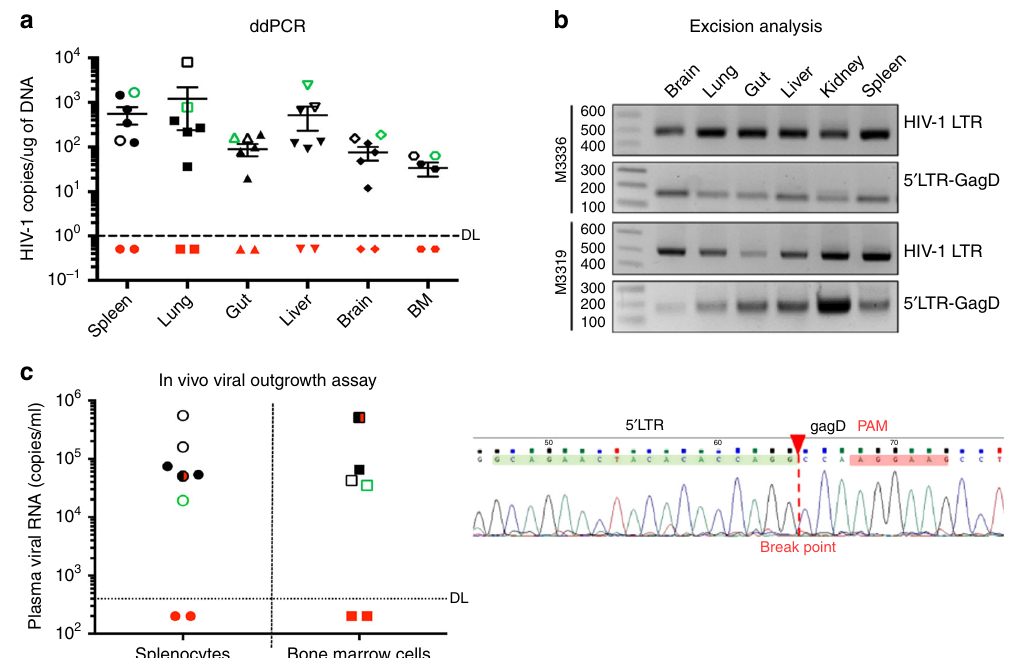
Fig. 8 Con fi rmation of viral elimination in HIV-1 infected and treated mice tissues. a Ultrasensitive ddPCR, with sensitivity of detecting 1 – 2 viral copies, was used in cross validation tests for viral DNA detection and performed in tissues of HIV-1 ADA -infected and infected/dual-treated animals. As a positive control, one animal each from the HIV-1 infected (open black structure) and HIV-1 and LASER ART (open green structure) groups are illustrated. These were placed together with the six infected animals from the dual treatment group illustrated as closed structures (either black or red). Dashed line represents the limit of detection. Results are shown as the mean ± SEM (BM: bone marrow). b Agarose gel analyses of the PCR assay of DNA from various tissues of two animals with no rebound shows the presence of segments of HIV-1 LTR DNA and detection of a 193 bp amplicon, indicative of excision of a DNA fragment between the LTR and the gag gene (top). The histogram illustrates representative results from sequencing of the 193 bp fragment highlighting the position of the 5 ’ LTR breakpoint, and Gag and PAM trinucleotide on the GagD RNA. c An in vivo viral outgrowth assay was performed by adoptive transfer of splenocytes and bone marrow cells from infected and virus eradicated LASER ART + CRISPR Cas9-treated mice to uninfected recipient CD34 + NSG-hu mice. These animals failed to show viral recovery after one month of examination by plasma viral RNA measurements. Con fi rmation assays were performed as positive controls: two animals from an HIV-1 infected group (open black circles for spleen and boxes for bone marrow) and an animal from a LASER ART treatment group are shown as open green circles (spleen) and box (bone marrow). All controls readily recovered virus. Five animals from the dual treatment group are illustrated as closed circles (spleen) and boxes (bone marrow). Virus was not detected in plasma from animals injected with splenocytes and bone marrow cells isolated from 2 dual-treated animals (M3319 and M3336, red circles and boxes) and used as the de fi nition of viral eradication. Source data are provided as a source data fi and Gag to 3 ’ LTR were estimated to be about 80% for both (100%-19.7% or100% - transcription (Invitrogen). For gRNA expression screening speci fi c reverse primer 19.5%). In the spleen of the same mouse, the AAV9 transduction ef fi ciency was (pX601gRNA scaffold/R, supplementary table 1) was used in RT reaction followed calculated as high as 1.03 AAV vector copies/cell in the total population including by standard PCR using target LTR 1 or GagD sense oligos as forward primers both human graft and mouse host cells (Fig. 6g). In another mouse M4346 (Source (supplementary table 1) and agarose gel electrophoresis. For checking saCas9 Data fi le for Fig. 6e), we demonstrated that the excision occurred mainly in Gag to mRNA expression oligo-dT primer mix was used in RT and cDNA was subjected 3 ’ LTR because the ratio of Pol/LTR is 38.4% while Gag/LTR is 89.5%. Thus, the to PCR using saCas9 speci fi c primer pairs and β -actin as a reference excision ef fi ciency was estimated at 61.6% in 5 ’ LTR to Gag and 10.5% in Gag to (supplementary table 1). Sanger sequencing results were analyzed using Clustal 3 ’ LTR. Nonetheless, the presence of 2 LTRs in an uncut HIV proviral DNA was not Omega (EMBL-EBI) multiple sequence alignment tool and Sequence Scanner considered in order to simplify the estimate. Software 2 (Applied Biosystems). ddPCR for detection of HIV-1 nucleic acids . ddPCR was performed based on the water – oil emulsion droplet technology, using the ddPCR ™ Supermix for Probes